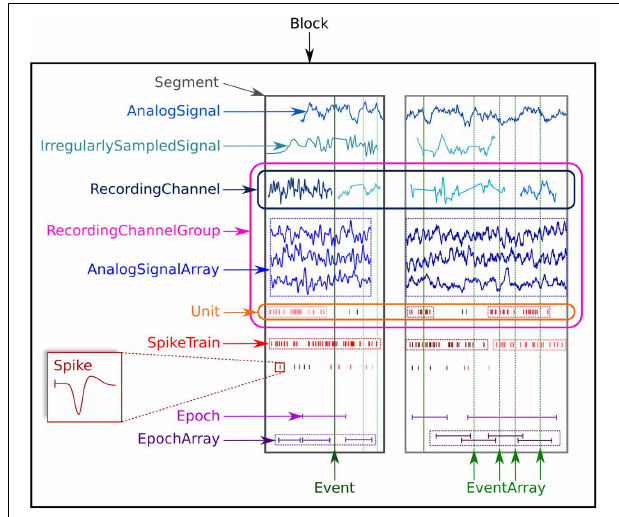
FIGURE 1 | An illustration of the data types supported by Neo and their grouping into